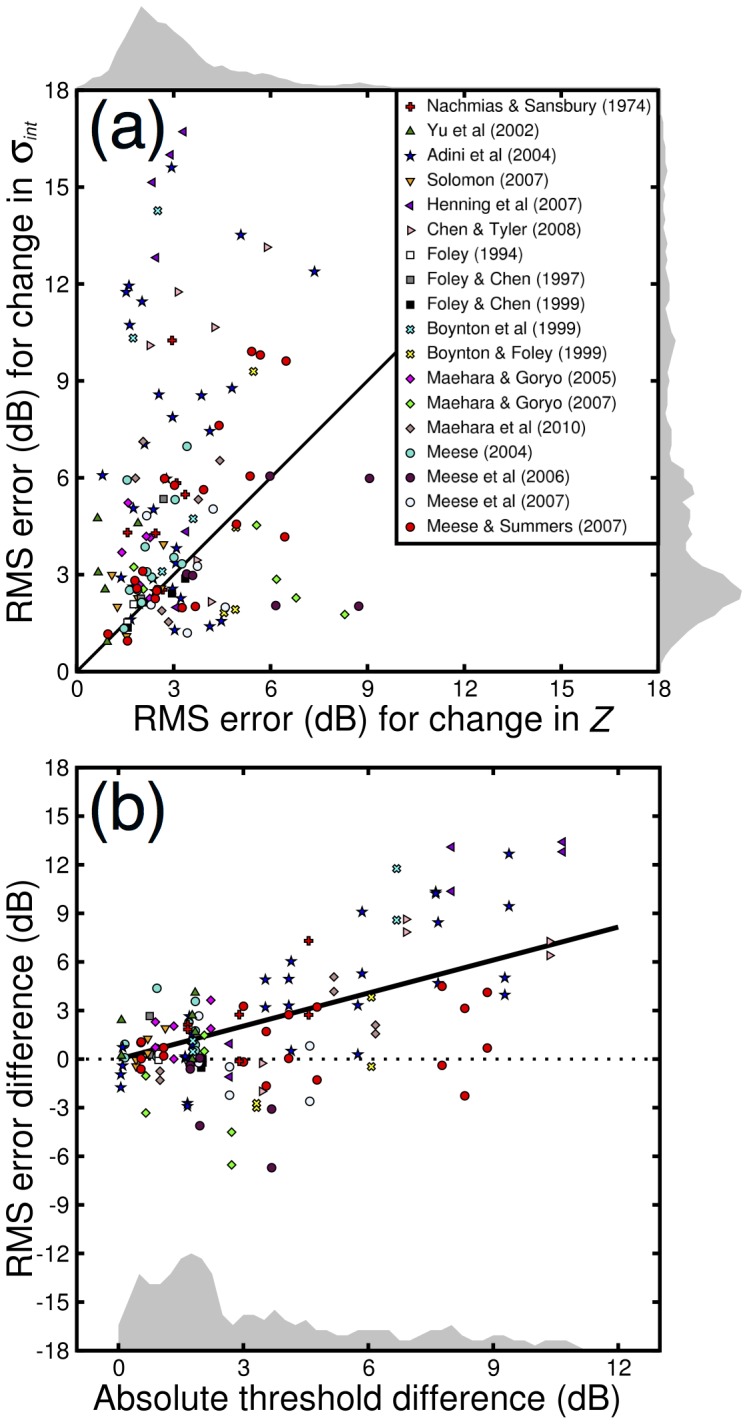
Scatterplots showing RMS errors for fits to 138 pairs of dipper functions.In (a), points above the oblique line indicate that changing σint produced a worse fit (larger error) than changing Z. In (b), the difference between the two errors is plotted against the absolute difference in detection threshold for each pair of dippers. Points above the dotted line correspond to points above the oblique line in panel (a). For pairs with the largest threshold differences (e.g. >6dB) almost all points favour the change in Z. The solid black line is the best fitting regression line, constrained to pass through [0,0], and has a slope of 0.68. The shaded histograms in each panel show the density of points. Since these exhibit positive skew, the data were log-transformed before performing statistical tests.